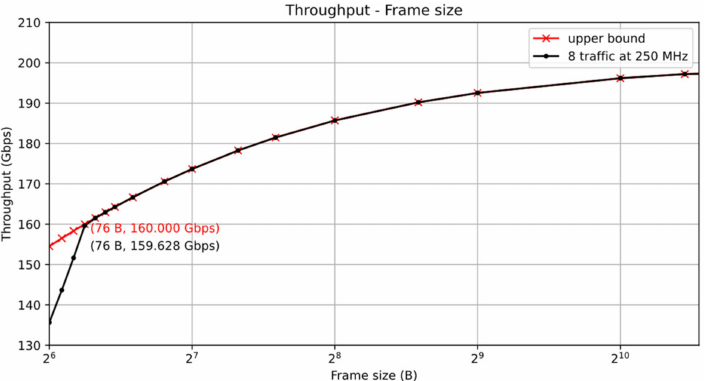
Figure 6. Throughput in reference to frame